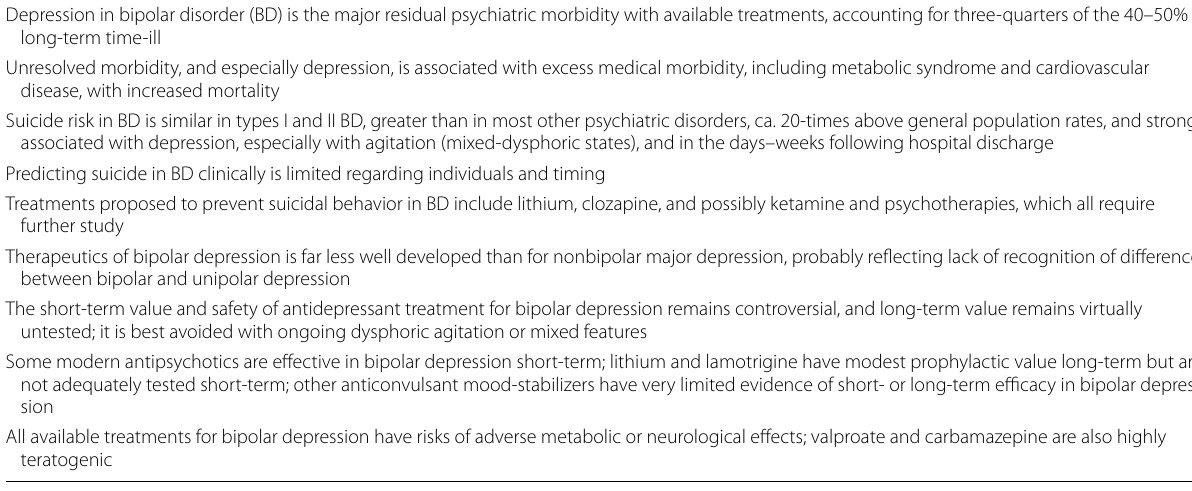
Table 5 Current status of depression in bipolar disorder Depression in bipolar disorder (BD) is the major residual psychiatric morbidity with available treatments, accounting for three-quarters of the 40–50% long-term time-ill Unresolved morbidity, and especially depression, is associated with excess medical morbidity, including metabolic syndrome and cardiovascular disease, with increased mortality Suicide risk in BD is similar in types I and II BD, greater than in most other psychiatric disorders, ca. 20-times above general population rates, and strongly associated with depression, especially with agitation (mixed-dysphoric states), and in the days–weeks following hospital discharge Predicting suicide in BD clinically is limited regarding individuals and